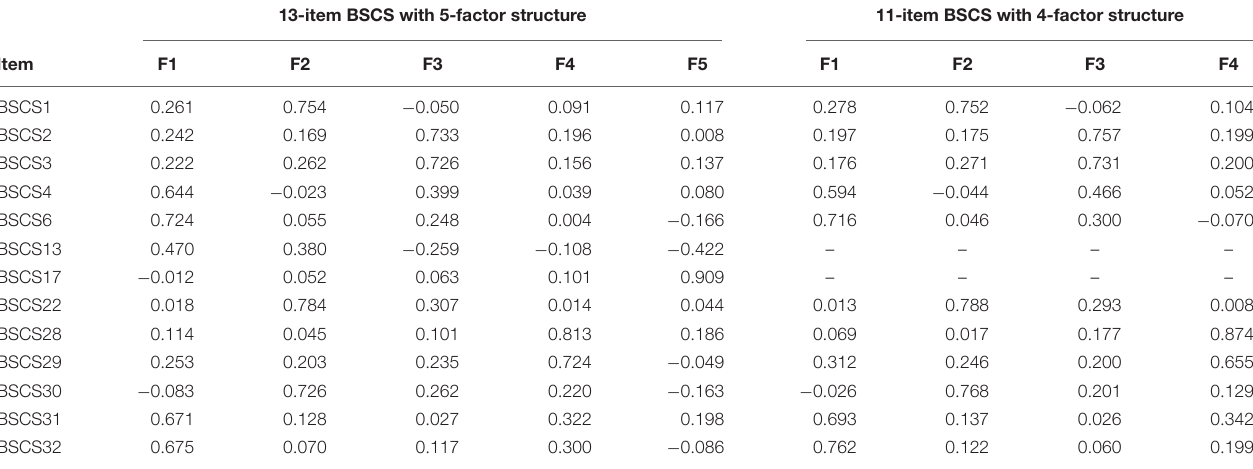
TABLE 4 | Factor loading for the Brief Self-Control Scale. 13-item BSCS with 5-factor structure 11-item BSCS with 4-factor structure